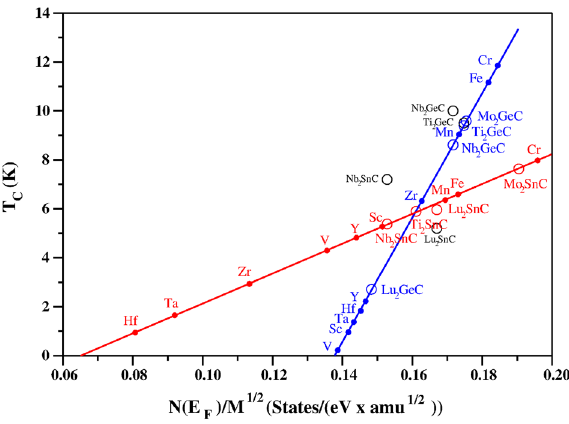
Figure 2. T c for M 2 AC (M: Sc, Ti, V, Cr, Mn, Fe, Y, Zr, Nb, Mo, Lu, Hf and Ta; A: Ge and Sn). The results for T c calculated using µ ∗ = 0.13 using Migdal-Eliashberg theory are presented as blue (A = Ge) and red (A = Sn) open circles, and the corresponding experimental data are displayed as black circles, with linear best fit to the theoretical values in blue and red lines. Red and blue filled circles represent a simple Fröhlich model for estimating superconducting transition temperature T c . Full data in Tables 1 and 2.